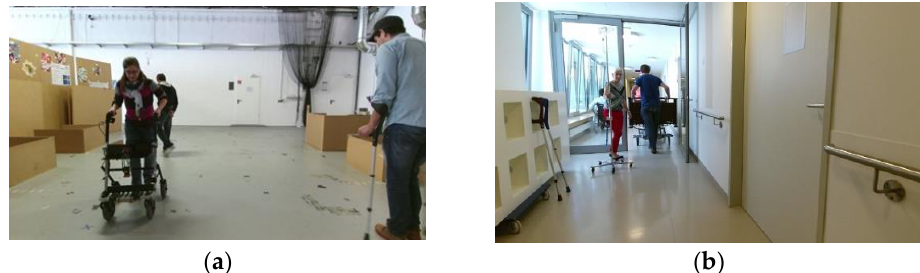
Figure 5. Samples from the Mobility Aids dataset [47]. ( a ) Scene from a large room with various actors walking around. ( b ) Scene of a narrow hallway featuring occlusion and people who are easy to misclassify.